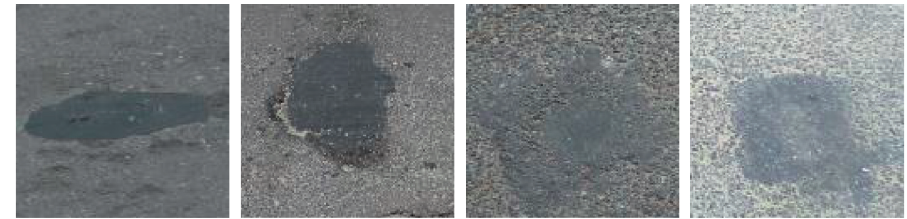
Figure 2: Appearances of patched potholes in the asphalt pavement